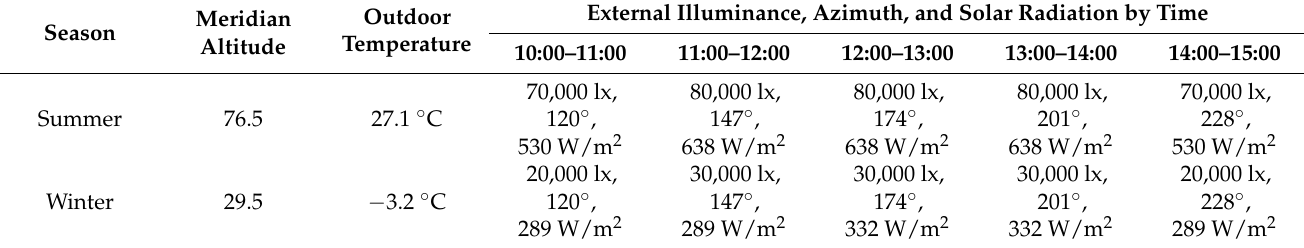
Table 4. Solar altitude and external illuminance during summer, mid-season, and